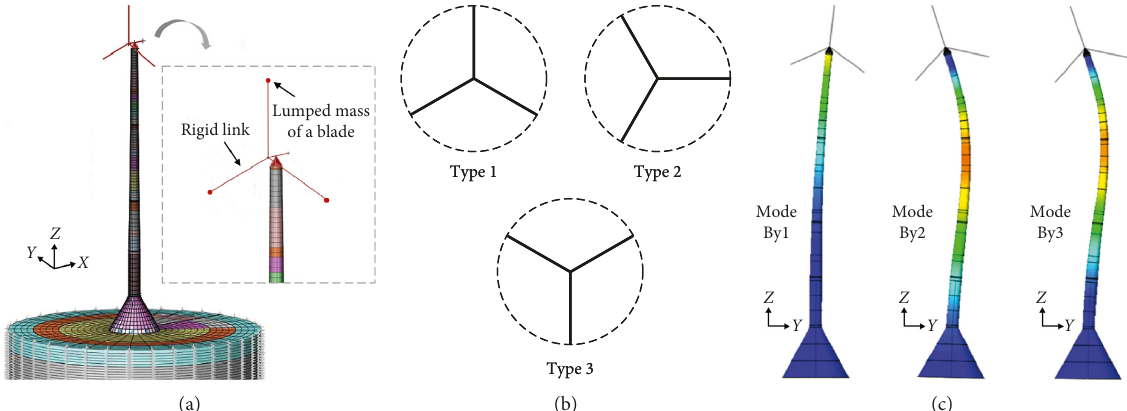
Figure 5: Blades-detailed FE model and its eigenvalue analysis for three orientation types of blades. (a) Modeling of blades. (b) Orientations of blades (c) Mode shapes of modes